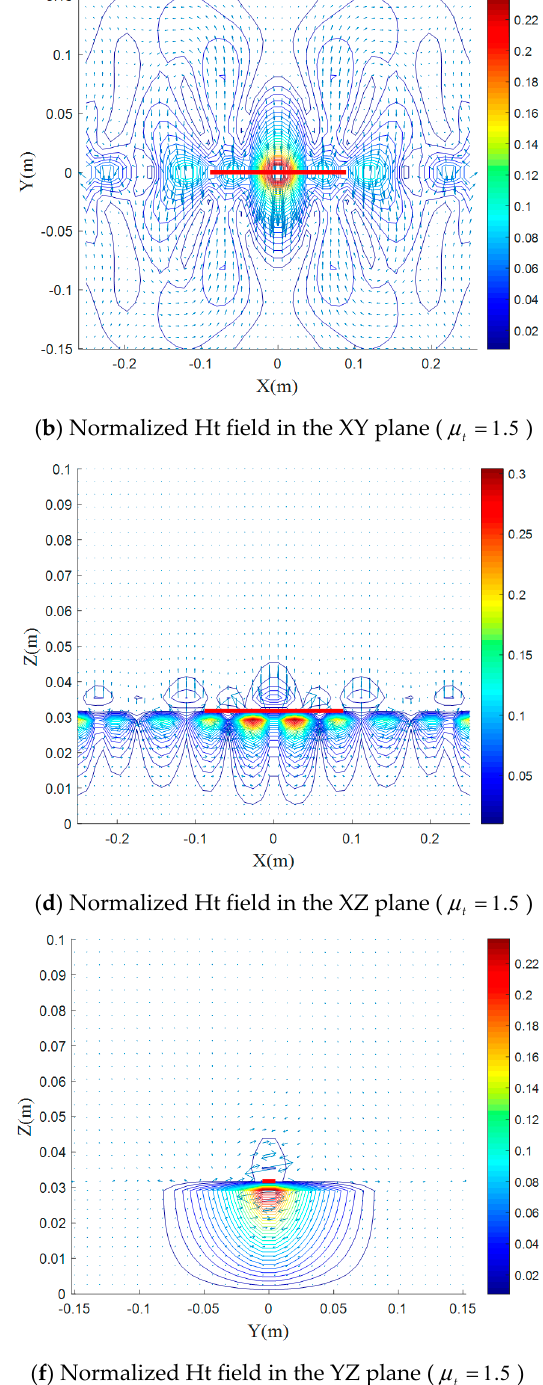
Figure 11. ( a – f ) Normalized magnetic field distributions for various values of µ t with ε z = ε t = 3.25 and µ z = 1, in the XY, XZ, and YZ plane.